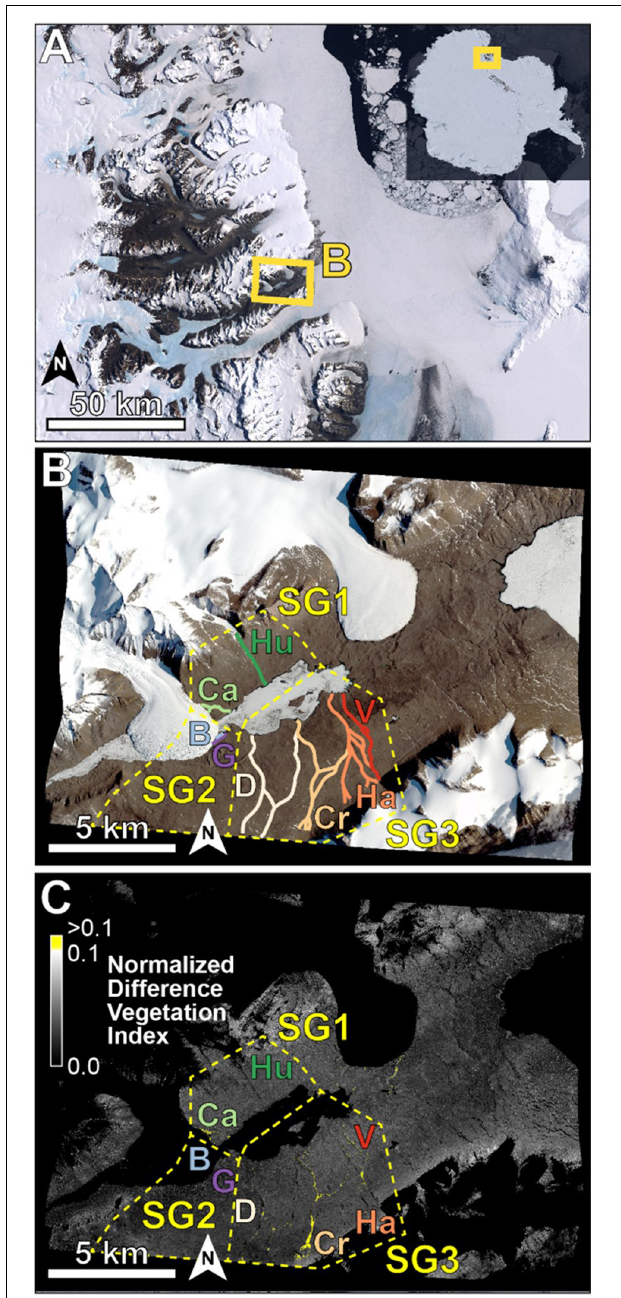
FIGURE 2 | Maps of (A) the location of the study area (Fryxell Basin) in the McMurdo Dry Valleys in Antarctica, (B) a visible remote image of Fryxell Basin (acquired 21 January 2015 GMT) with stream channels highlighted (labeled clockwise, Ca, Canada Stream; Hu, Huey; V, Von Guerard; Ha, Harnish; Cr, Crescent; D, Delta; G, Green Creek; B, Bowles), and (C) the NDVI metric calculated for habitats other than ice and water. Yellow patches represent areas of high NDVI values ( > 0.1) present within the Fryxell basin. These patches highlight regions of high photosynthetic mat coverage associated with perennial stream channels. Regions of shadow, ice, snow, and high elevation and steep slopes have been excluded from this thresholding to highlight regions of interest. Approximate outlines of stream group ( Table 1 ) areas are indicated by dotted lines in (B,C) . Imagery © 2015 DigitalGlobe,